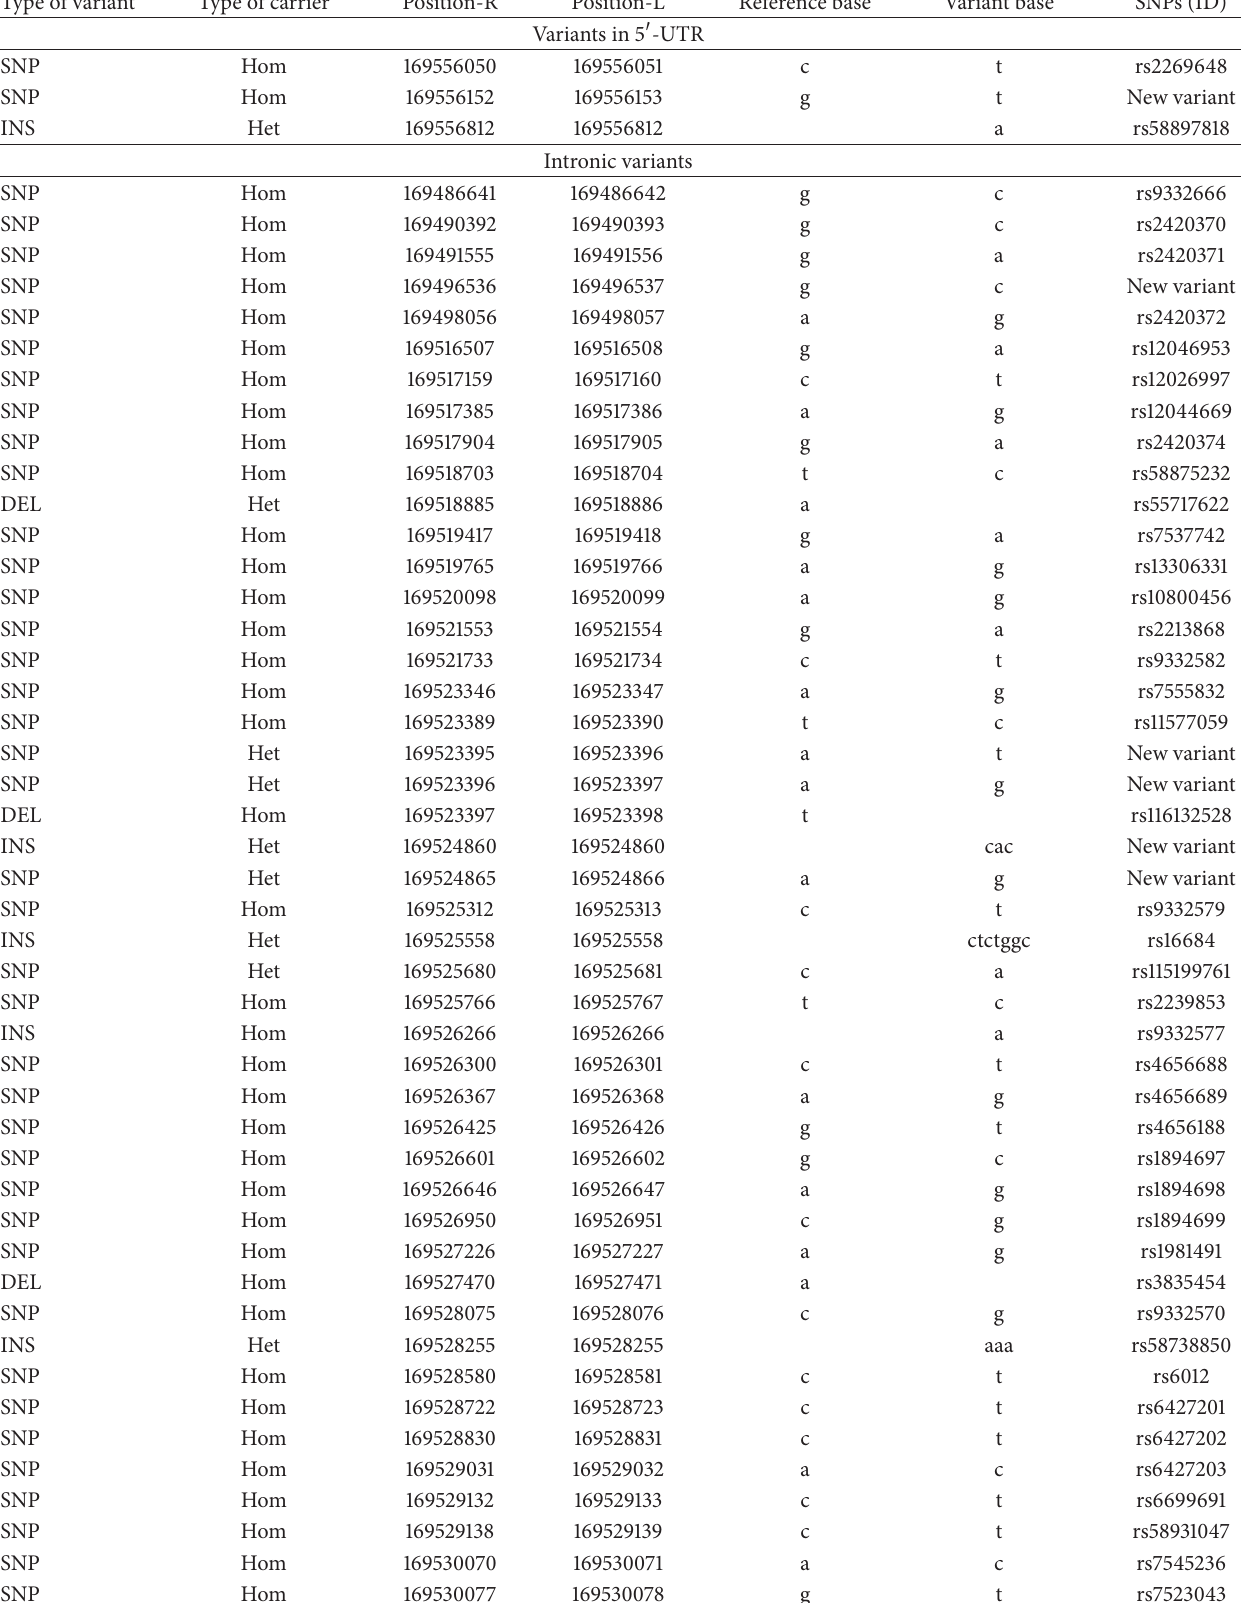
Table 3: Summary of observed variants in noncoding sequences of F5 gene in investigated